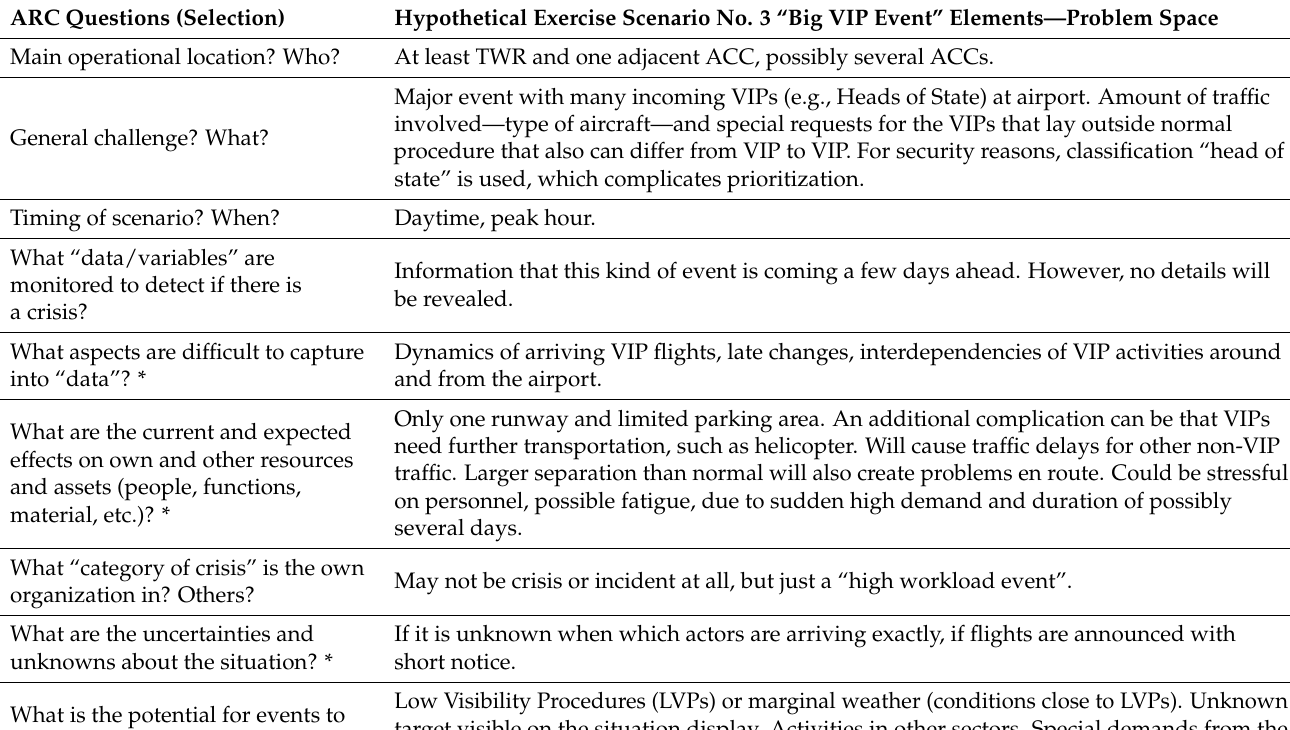
Table 7. Hypothetical exercise scenario elements. Examples of questions that may be used to generate scenario injects (what-if’s) to “control the heat” before/during the exercise are indicated with